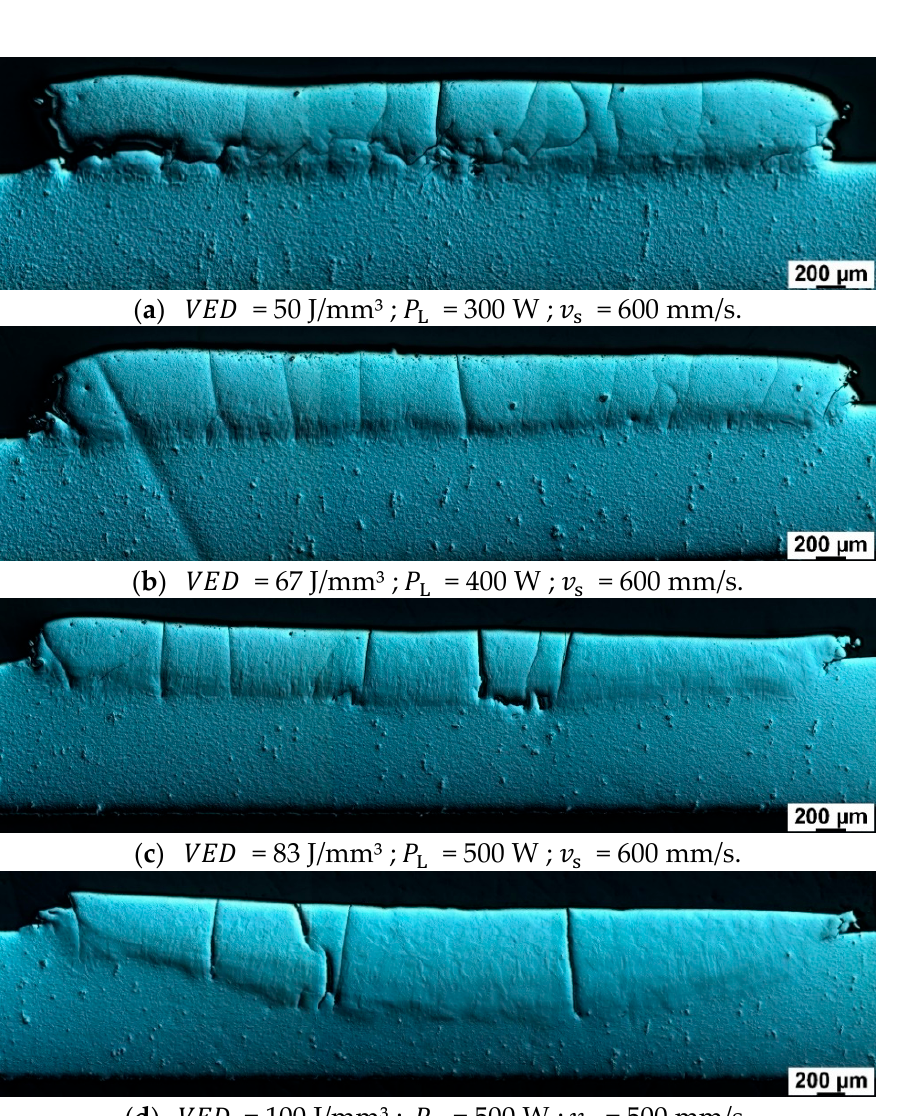
( d ) 𝑉𝐸𝐷 = 100 J/mm³ ; 𝑃 = 500 W ; 𝑣 = 500 mm/s. (cid:2896) (cid:2929) Figure 7. Microsections taken with the interference filter of a cross ‐ sectional cut of: ( a ) MPEA_50, Figure 7. Microsections taken with the interference filter of a cross-sectional cut of: ( a ) MPEA_50, ( b ) MPEA_67, ( c ) MPEA_83, ( d ) MPEA_100. ( b ) MPEA_67, ( c ) MPEA_83, ( d )